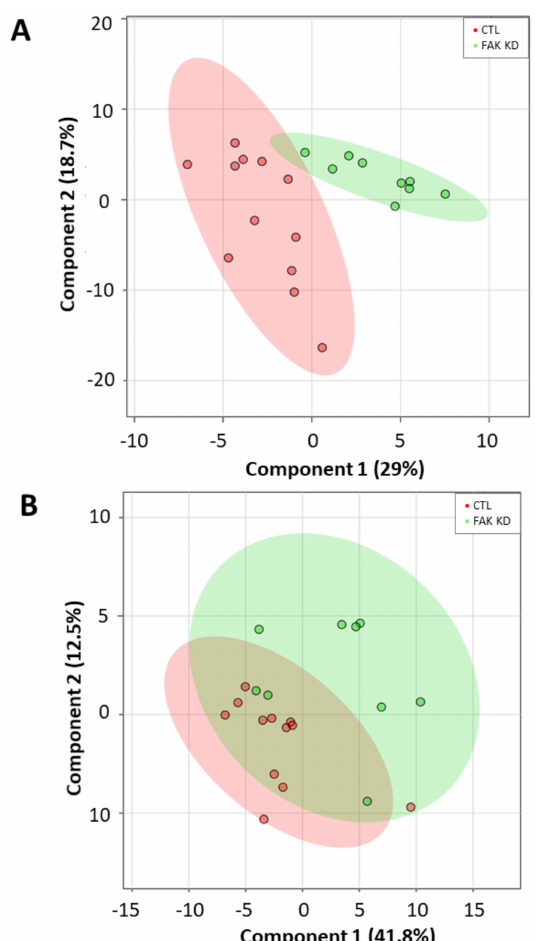
Figure 7. Discriminant ability of lipid signature in Huh-7 / HepG2 cells depleted for FAK. ( A ) Partial least squares discriminant analysis (PLS-DA) score plot showing separation between KD Huh-7 cells (green) and control cells (red). ( B ) PLS-DA score plot showing separation between KD HepG2 cells (green) and control cells (red). Number in parentheses is the percentage of explained